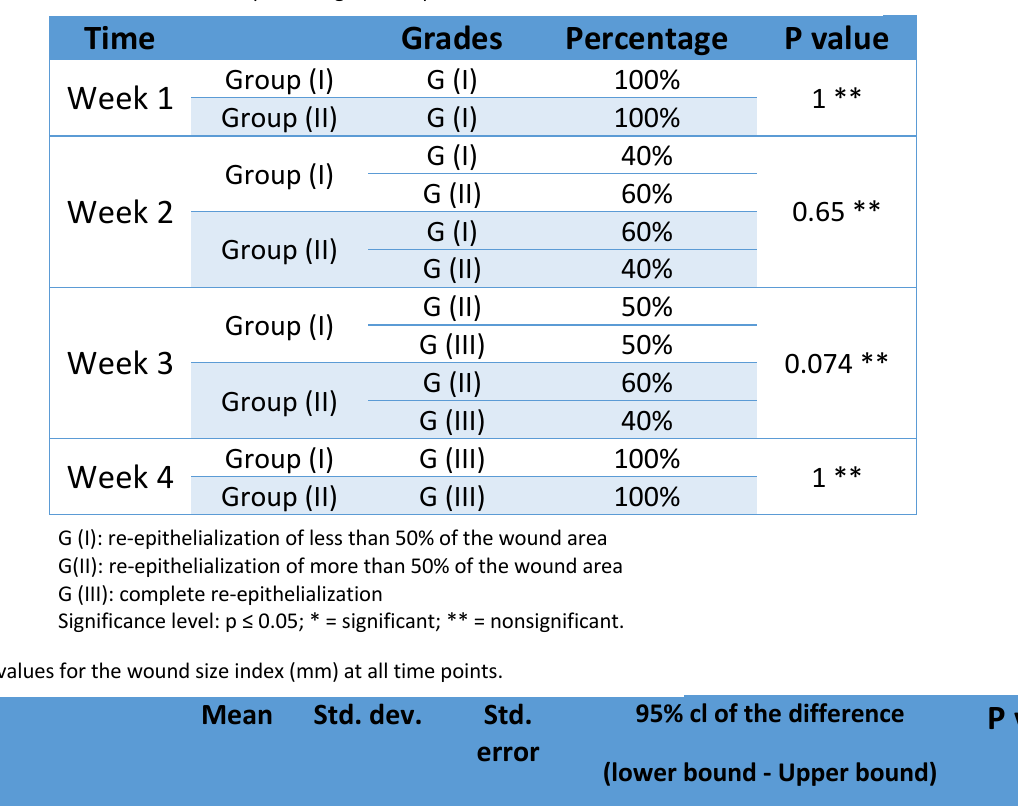
Table 5. Median and percentage of re-epithelialization from week 1 to week 4.